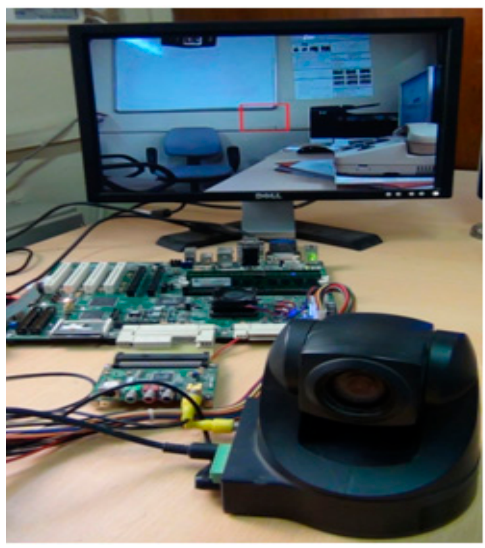
Figure 13. Complete object tracking system hardware setup. Table 1. FPGA resource utilization by object tracking architecture and four interfaces.